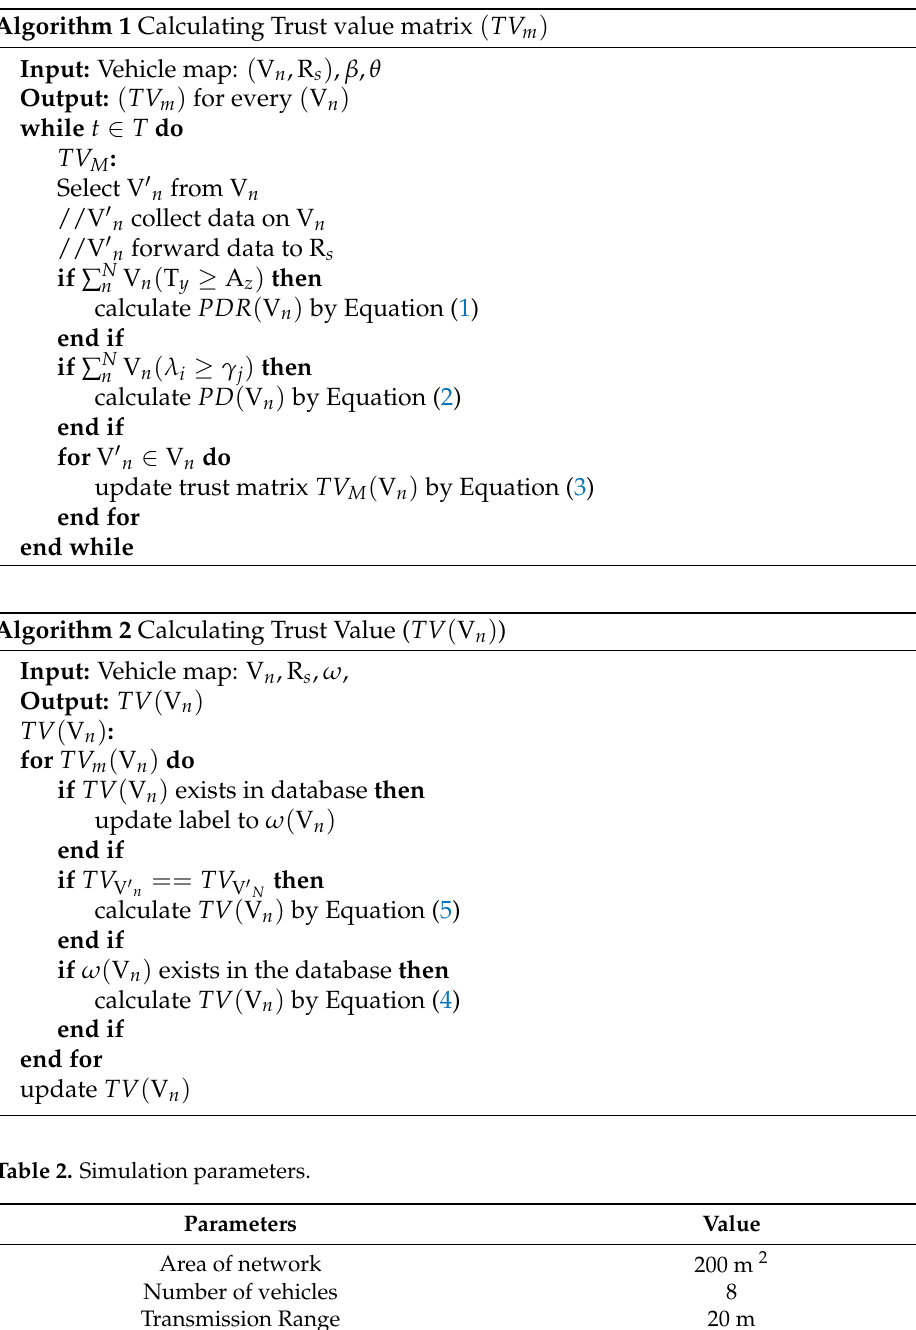
Algorithm 1 Calculating Trust value matrix ( TV m )